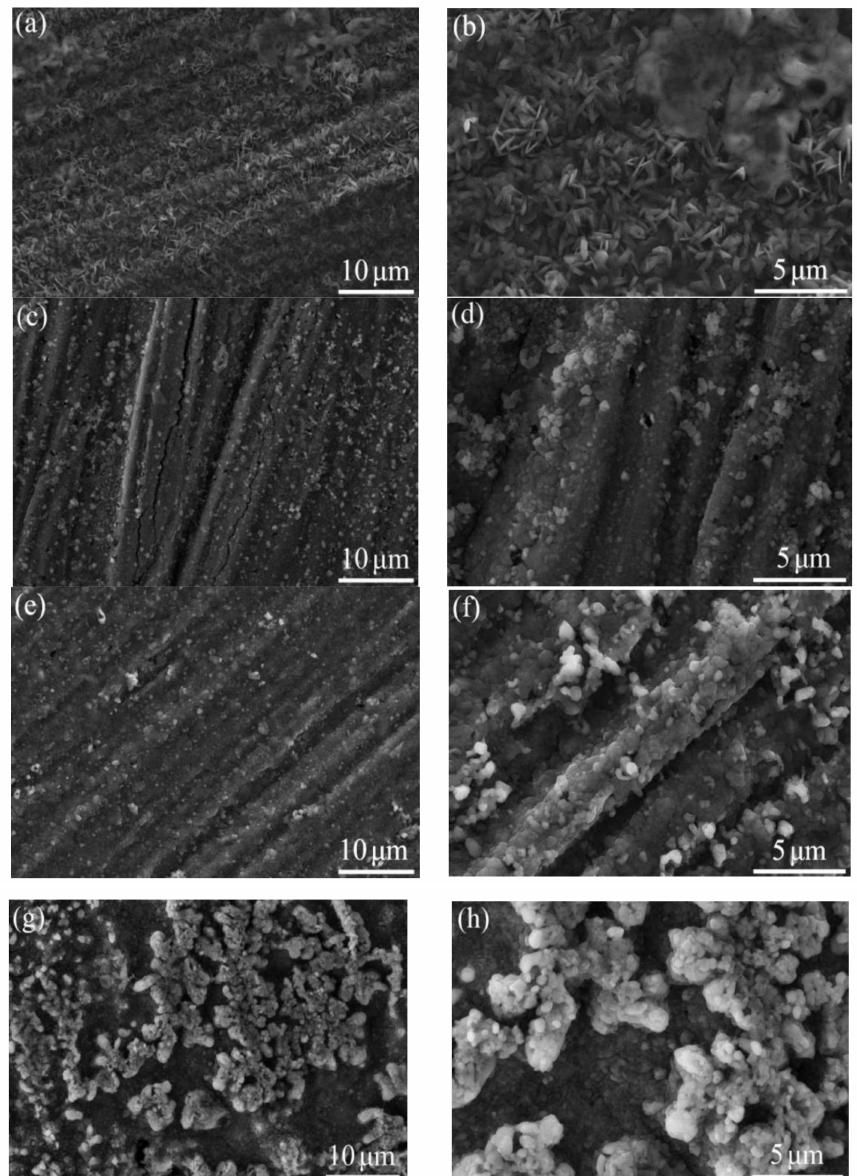
Figure 8. Morphology of oxide on the surface of the coatings. ( a , b ) As-sprayed, ( c , d ) VHT1000, ( e , f ) VHT1100, and ( g , h )